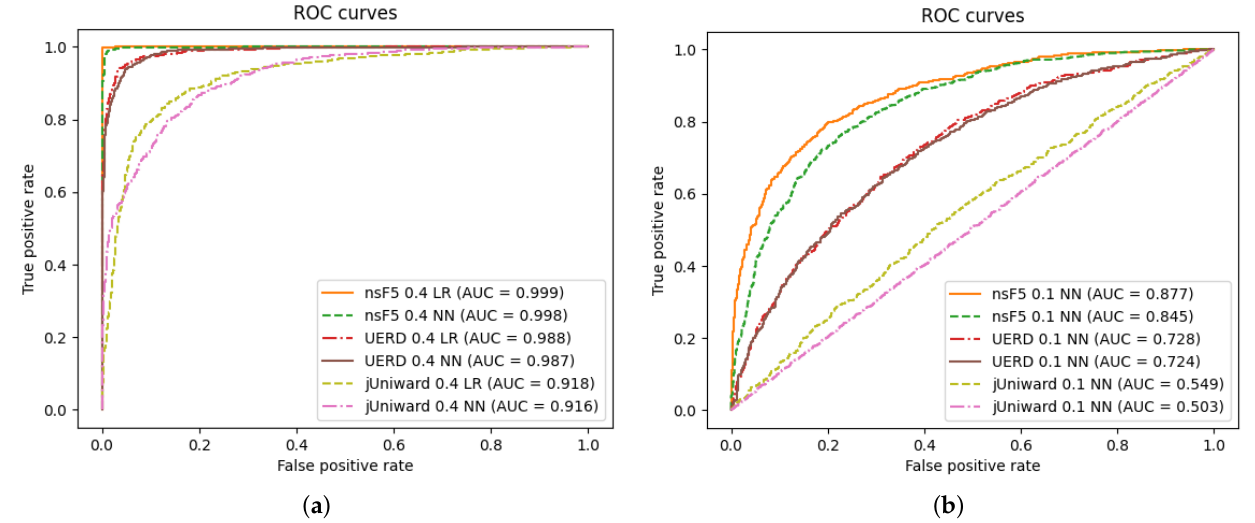
Figure 6. Comparison of ROC curves for the best neural network and the best ensemble classifier for data hidden ( a ) with density 0.4 bpnzac and ( b ) with density 0.1